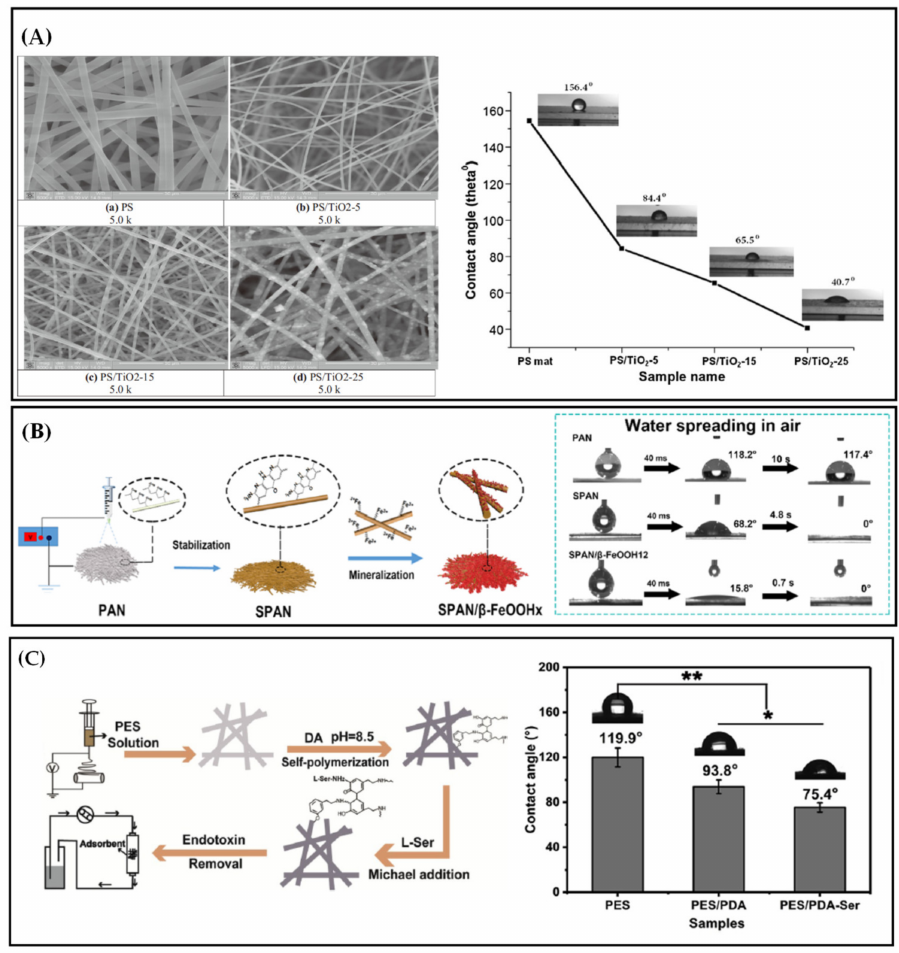
Figure 8. ( A ) SEM images and water contact angles of PS, PS/TiO 2 -5, PS/TiO 2 -15 and PS/TiO 2 - 25 fiber membranes [115]; ( B ) preparation process and water contact angles of SPAN/ β -FeOOHx nanofibers [118] and ( C ) preparation process and water contact angles of PES/L-Ser functional membranes